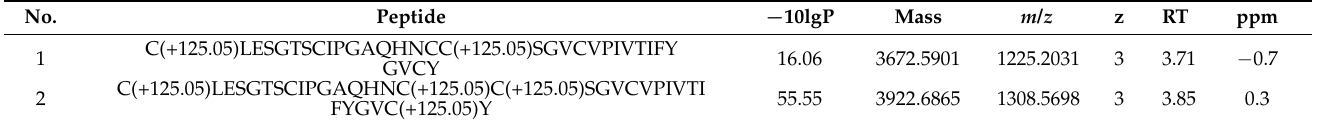
Table 1. TCEP/NEM step-by-step reduction of bidentatide to obtain disulfide bond information. No.